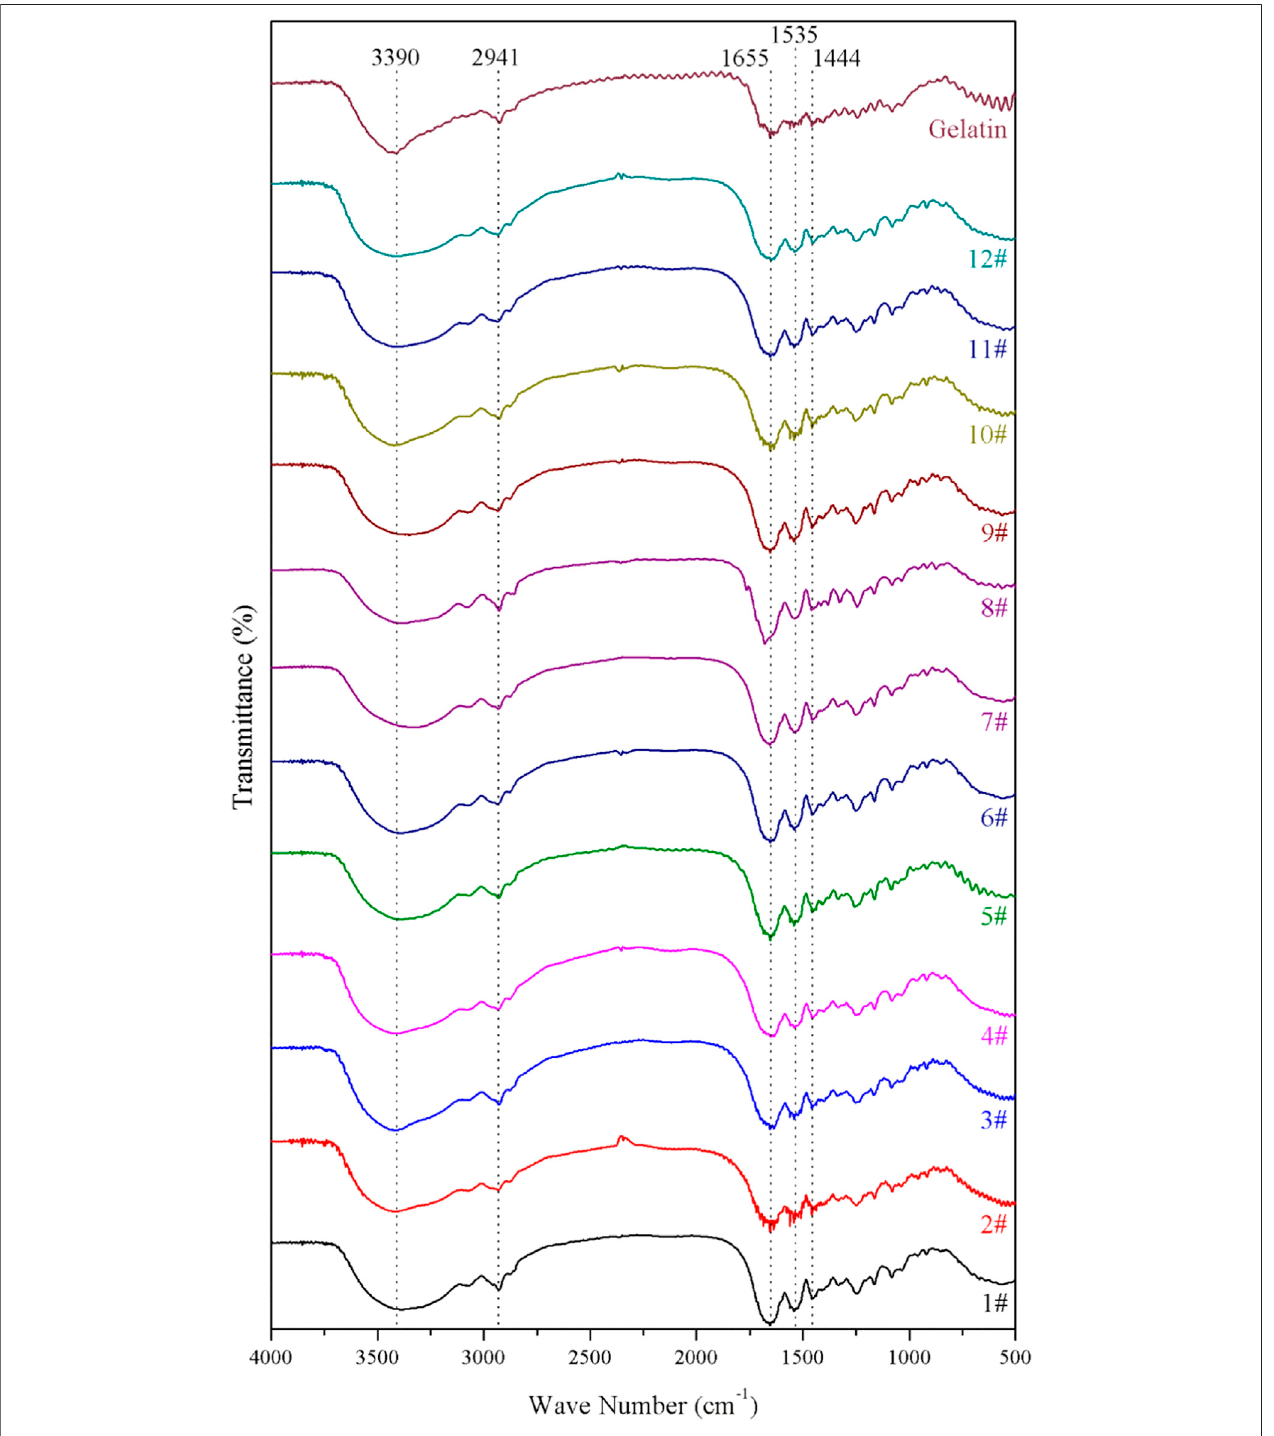
FIGURE 1 | The fourier-transform infrared (FTIR) spectra of the GelMA hydrogels with different freezing temperatures and time.